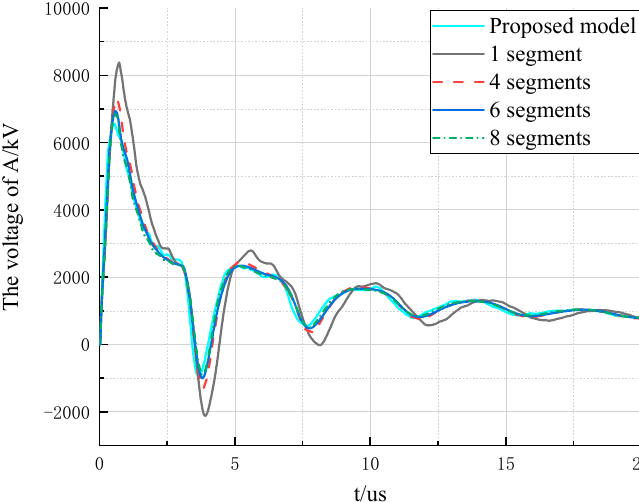
Figure 11. Simulation results of the voltage with the non-uniform transmission line model and with the multi-segment multi-surge model.